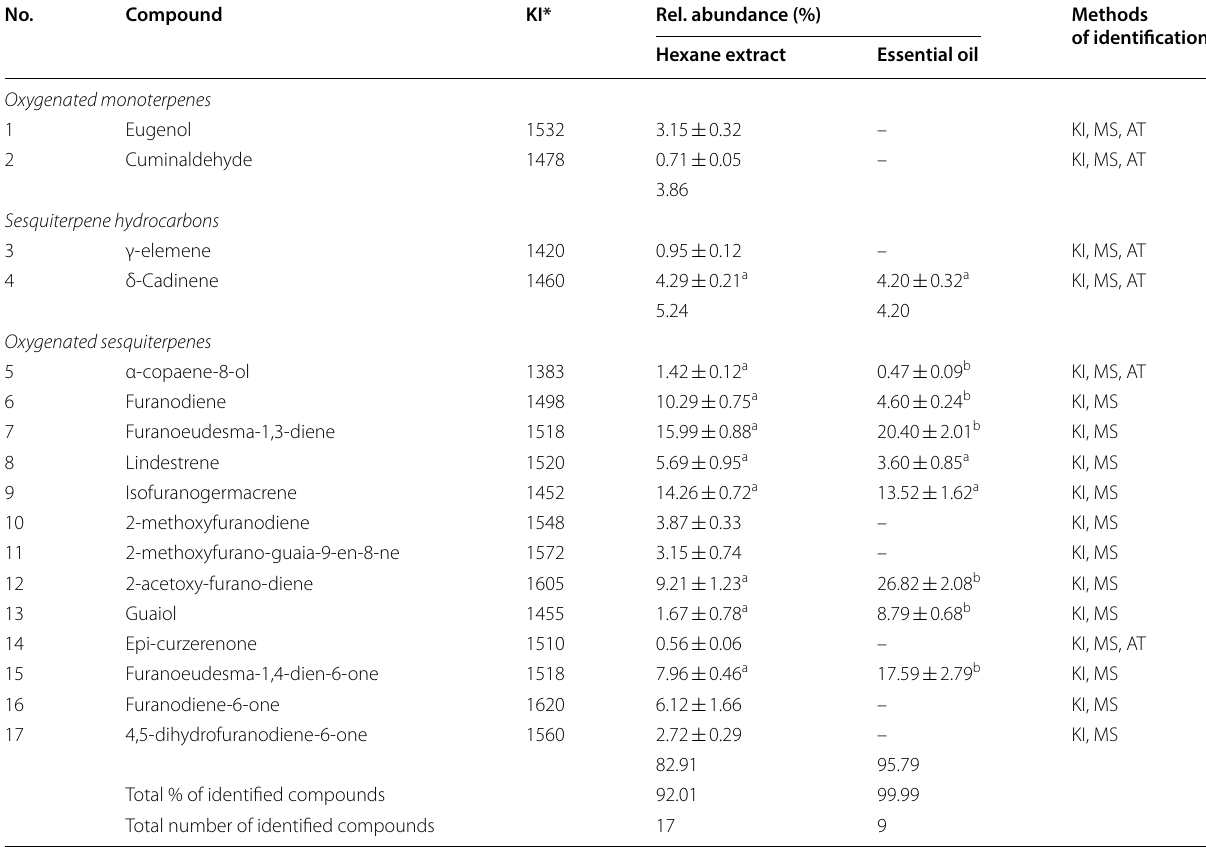
Table 7 Identified constituents in hexane extract and essential oil of Myrrh